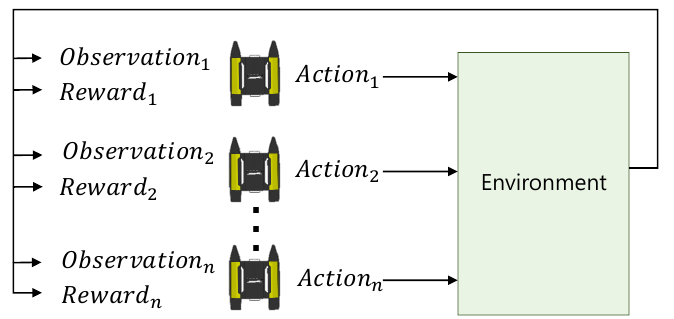
Figure 6. Multi-agent reinforcement learning: Multiple agents interact through observation and reward from the environment and learn the